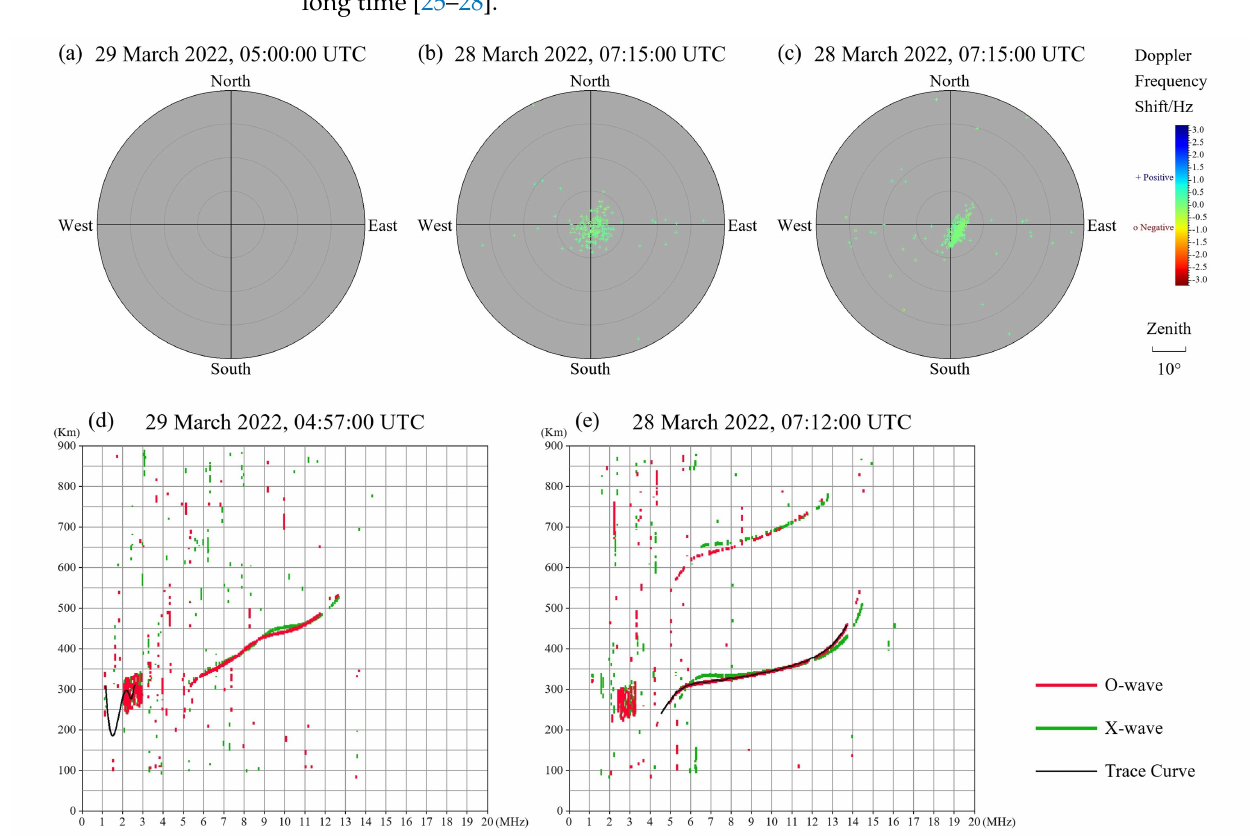
Figure 3. Demonstration of detection frequency selection and optimal height range restriction. ( a ) Invalid drift measurement results with no reasonable detection frequencies. ( b ) Invalid drift measurement results with reasonable detection frequencies but no reasonable optimal height range. ( c ) Valid drift measurement results with reasonable detection frequencies and a reasonable optimal height range. ( d ) Ionogram obtained 3 min before drift measurement ( a ). ( e ) Ionogram obtained 3 min before drift measurement ( b , c